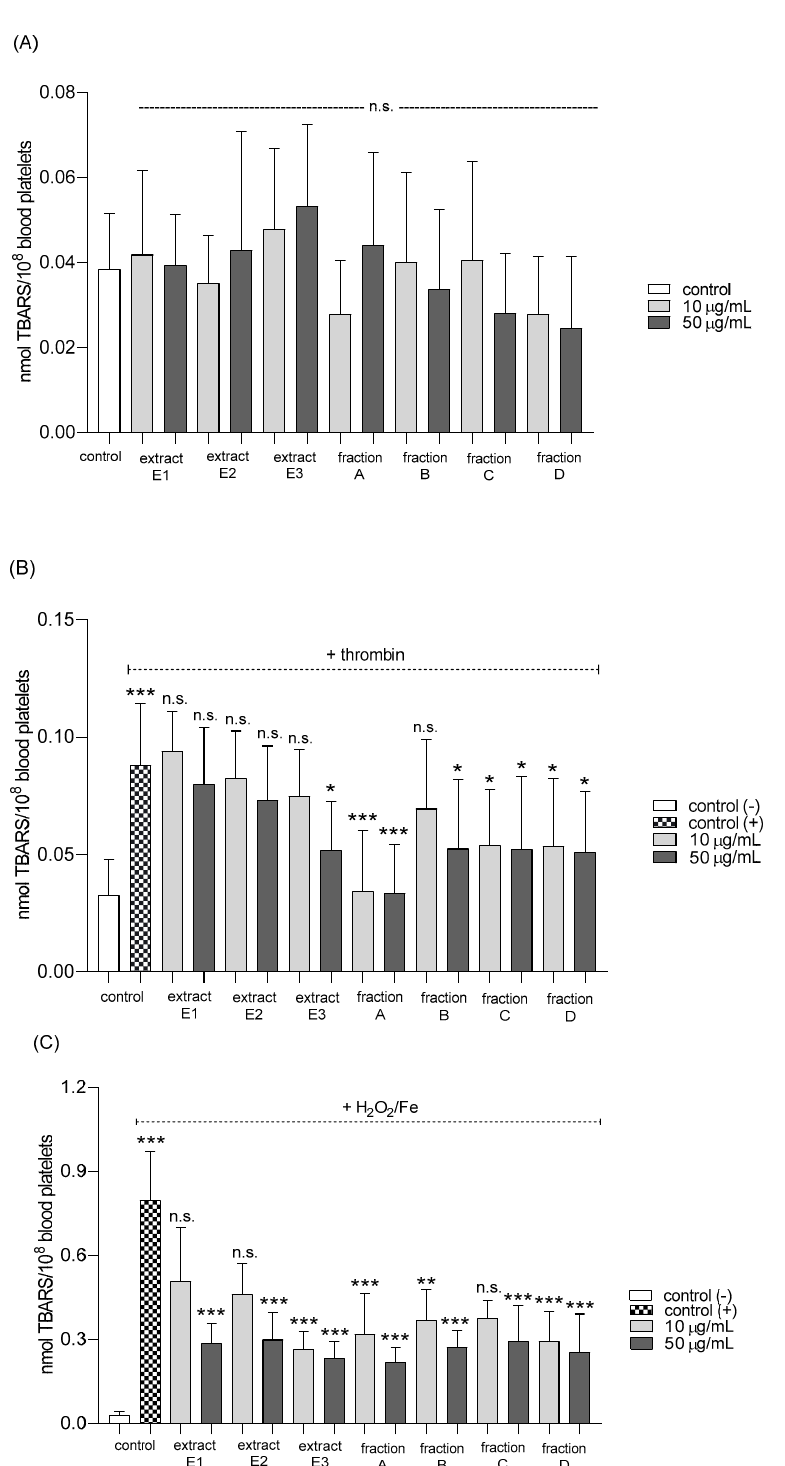
Figure 5. Effects of extracts (E1–E3) and flavonoid fractions (A–D) of dandelion fruits (concentrations 10 and 50 µg/mL) on lipid peroxidation in resting blood platelets ( A ), platelets activated by 5 U/mL thrombin ( B ), and platelets treated with H 2 O 2 /Fe ( C ). The data are presented as means ± SD ( n = 5). Control negative refers to platelets not treated with thrombin or H 2 O 2 /Fe, and control positive to platelets treated with thrombin or H 2 O 2 /Fe. Kruskal-Wallis test: n.s. p > 0.05, * p < 0.05, ** p < 0.01, *** p < 0.001.